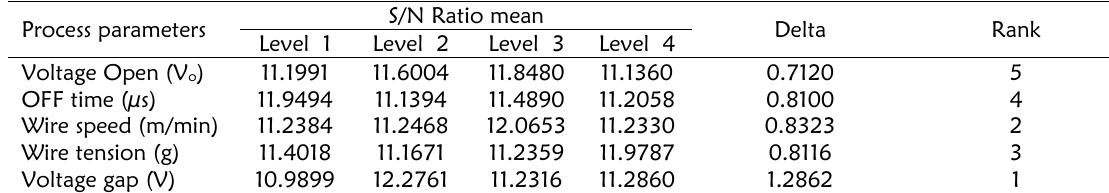
Table 5: S/N ratio means for kerf